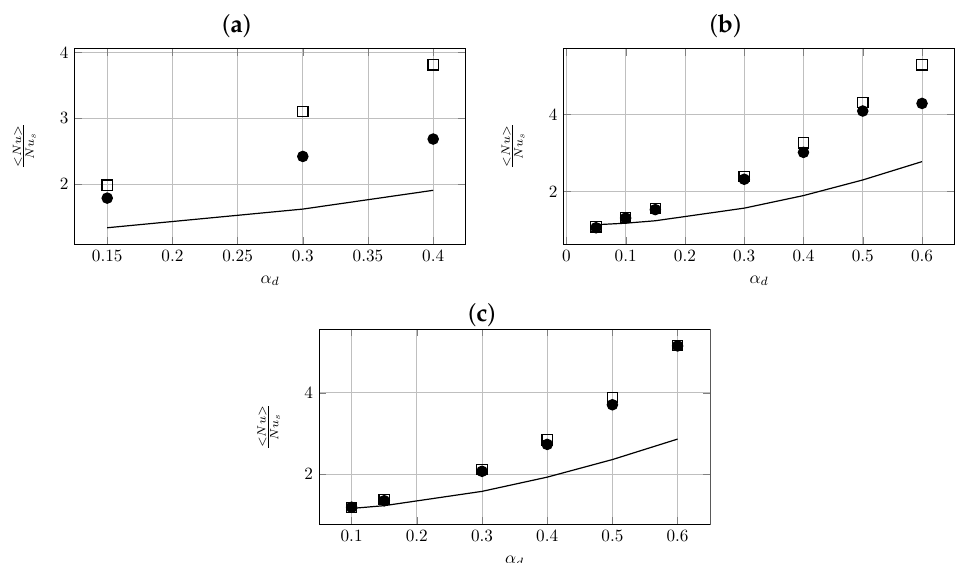
Figure 11. Global Nusselt coefficient for a uniform flow past a FCC, normalized by Ranz and Marshall [31] Nusselt coefficient for a uniform flow past an isolated sphere. Evolution as a function of the solid volume fraction α d at Reynolds numbers ( a ) Re = 10, ( b ) Re = 50, ( c ) Re = 100: ( ) Gunn [14], ( ) Massol [10], ( ) present